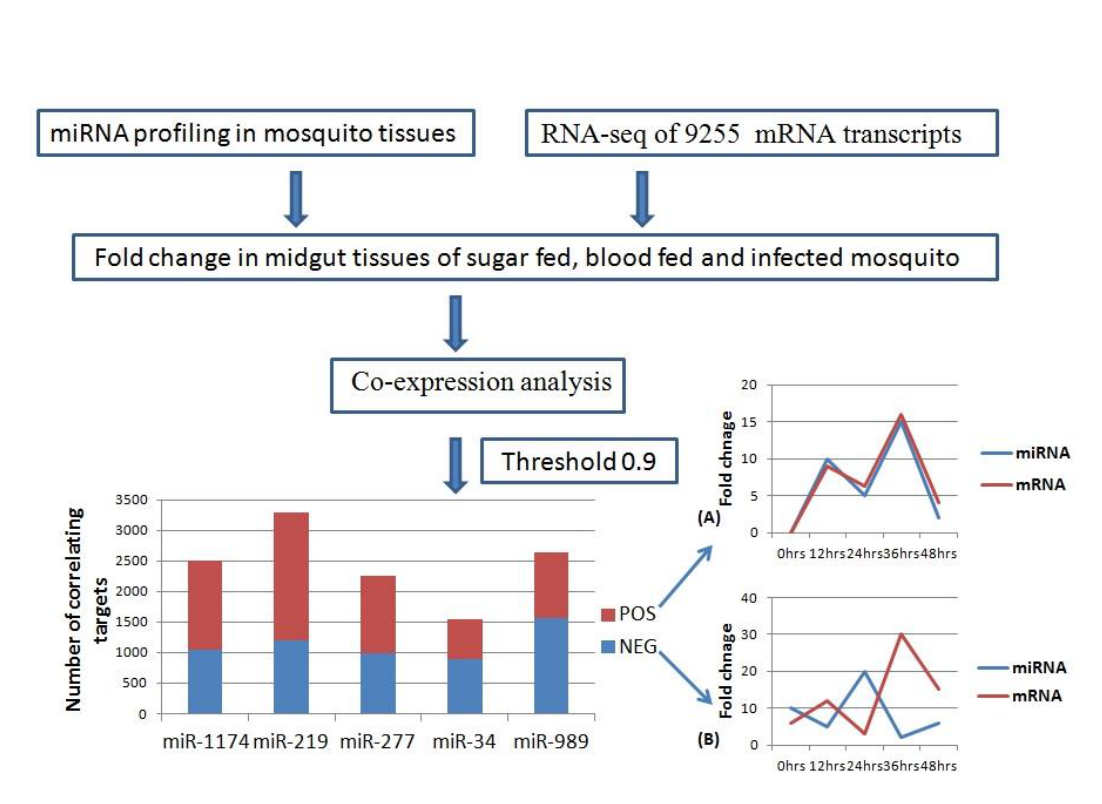
Figure 3. Workflow of miRNA and mRNA co-expression analysis. MicroRNA expression profile in mosquito midgut generated by real time profiling was taken as input data. RNA-Seq data of 9255 transcripts was used as second input data set. These two data sets were used to analyze miRNA: mRNA co-expression (Threshold = 0.9) in the midgut of the female mosquito. Bar graph depicts number of mRNAs showing positive (Red) and negative (Blue) correlation with miR-1174, miR-219, miR-277, miR-34, and miR-989, respectively in the mosquito midgut. ( A ) Line graph showing positive correlation between miRNA and mRNA over the time period of 0–48 h; ( B ) Line graph showing negative correlation between miRNA and mRNA over the time period of 0–48